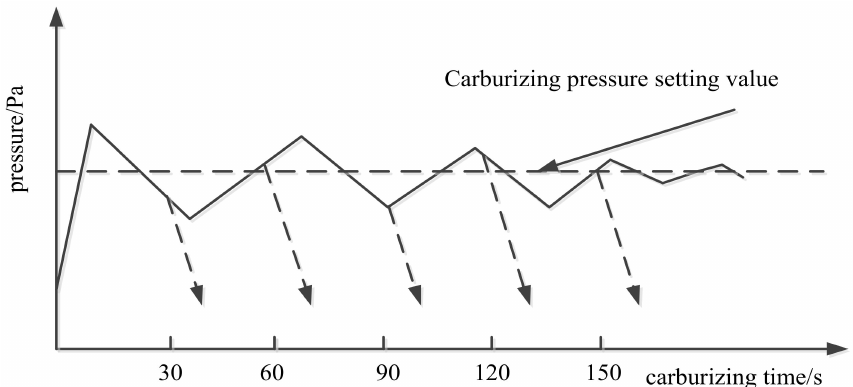
Figure 6. Schematic of the boost stages of the carburizing